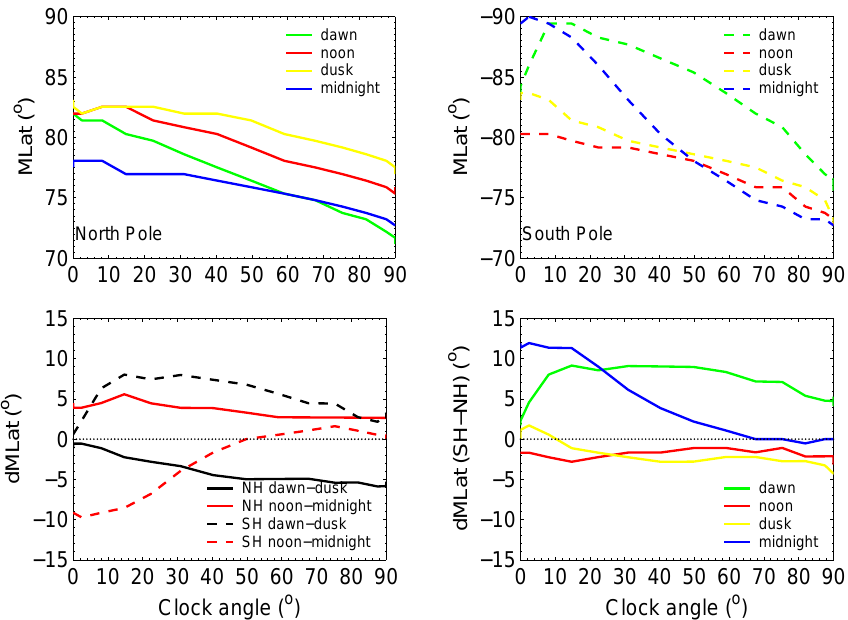
Fig. 7. Shift of the polar cap boundary with the changing clock angle. The top two panels show the time evolution of the open-close field line boundary in the noon, midnight, dawn, and dusk sectors in both hemispheres. Bottom left shows the local time difference of the open-closed boundary in the Northern and Southern Hemisphere. Solid lines are used for Northern Hemisphere conditions and dashed lines the Southern Hemisphere. The black line shows the dawn-dusk differences and red the noon-midnight differences. Bottom right shows the hemispheric latitude difference (summer–winter) of the open-close field line boundary in the noon, midnight, dawn, and dusk sectors as a function of the clock